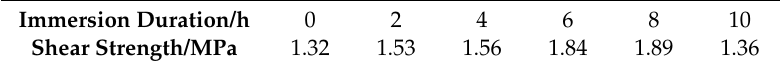
Table 2. Variation of the interfacial strength of SMA/epoxy composites after being modified by 2 wt % nano-silica and different acid immersion durations in the pull out